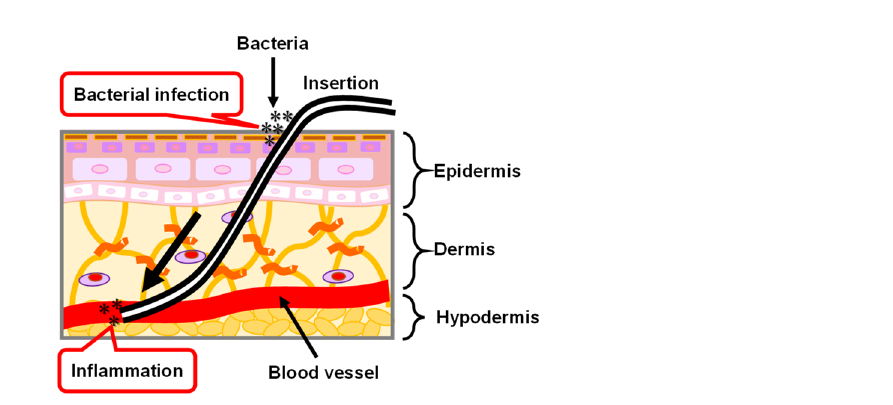
Figure 12. Illustration of skin structure and the problem of PI catheter applied in the biomedical application.